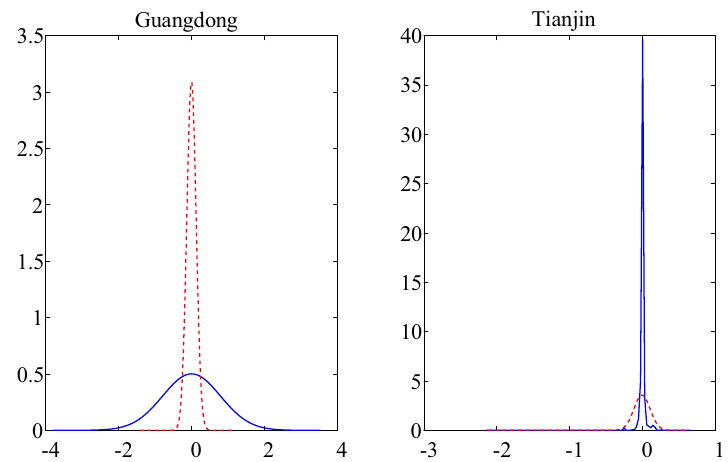
Fig. 3 Empirical distribution of energy-switching prices. Note: The solid line indicates the kernel estimate, and the dashed line indicates the Gaussian fit